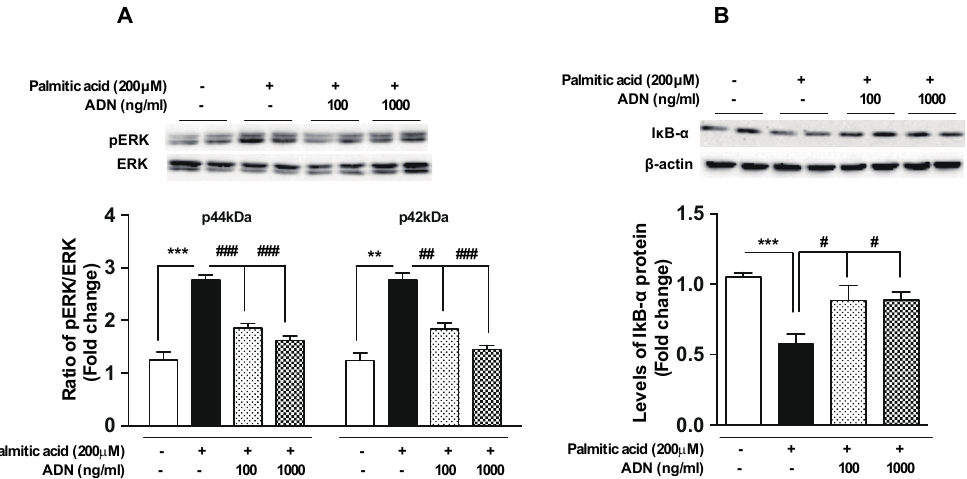
Figure 4. Adiponectin reverses palmitic acid-induced changes of the inflammatory mediators in the microglial cells. The BV-2 cells were seeded at a density of 1 × 10 6 cells / well and pretreated with adiponectin for 1 h followed by a palmitic acid (200 µ M) treatment for 30 min or 4 h. Palmitic acid-induced phosphorylation of ERK ( A ) and reduction of IkB- α synthesis ( B ) were reversed by adiponectin treatment at indicated concentration. Results are presented as mean ± SEM. ** p < 0.01 and *** p < 0.005 for palmitic acid-treated group versus vehicle-treated group; # p < 0.05, ## p < 0.01 and ### p < 0.005 for palmitic acid + adiponectin (AND)-treated group versus palmitic acid-treated group.